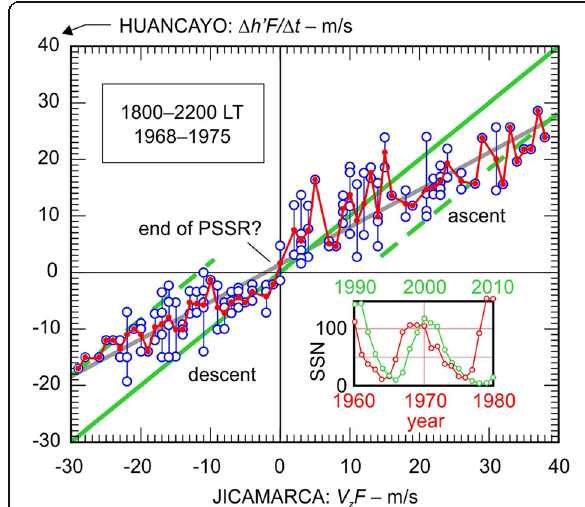
Fig. 4 Scatter plot of vertical velocities calculated from Δ h ’ F / Δ t over HUA, versus those from the Doppler velocity of IS returns measured with the JIC radar. The points, shown as blue circles with white fill, were scaled and replotted from a figure in Rastogi et al. (1991). The red dots represent averages of Δ h ’ F / Δ t values that are clustered about a plotted V z F value. The label for zero velocity has a question mark because there may be points included that are not from the end of the PSSR. Inset: mean SSNs for years 1960 to 1980 (red), and 1990 to 2010